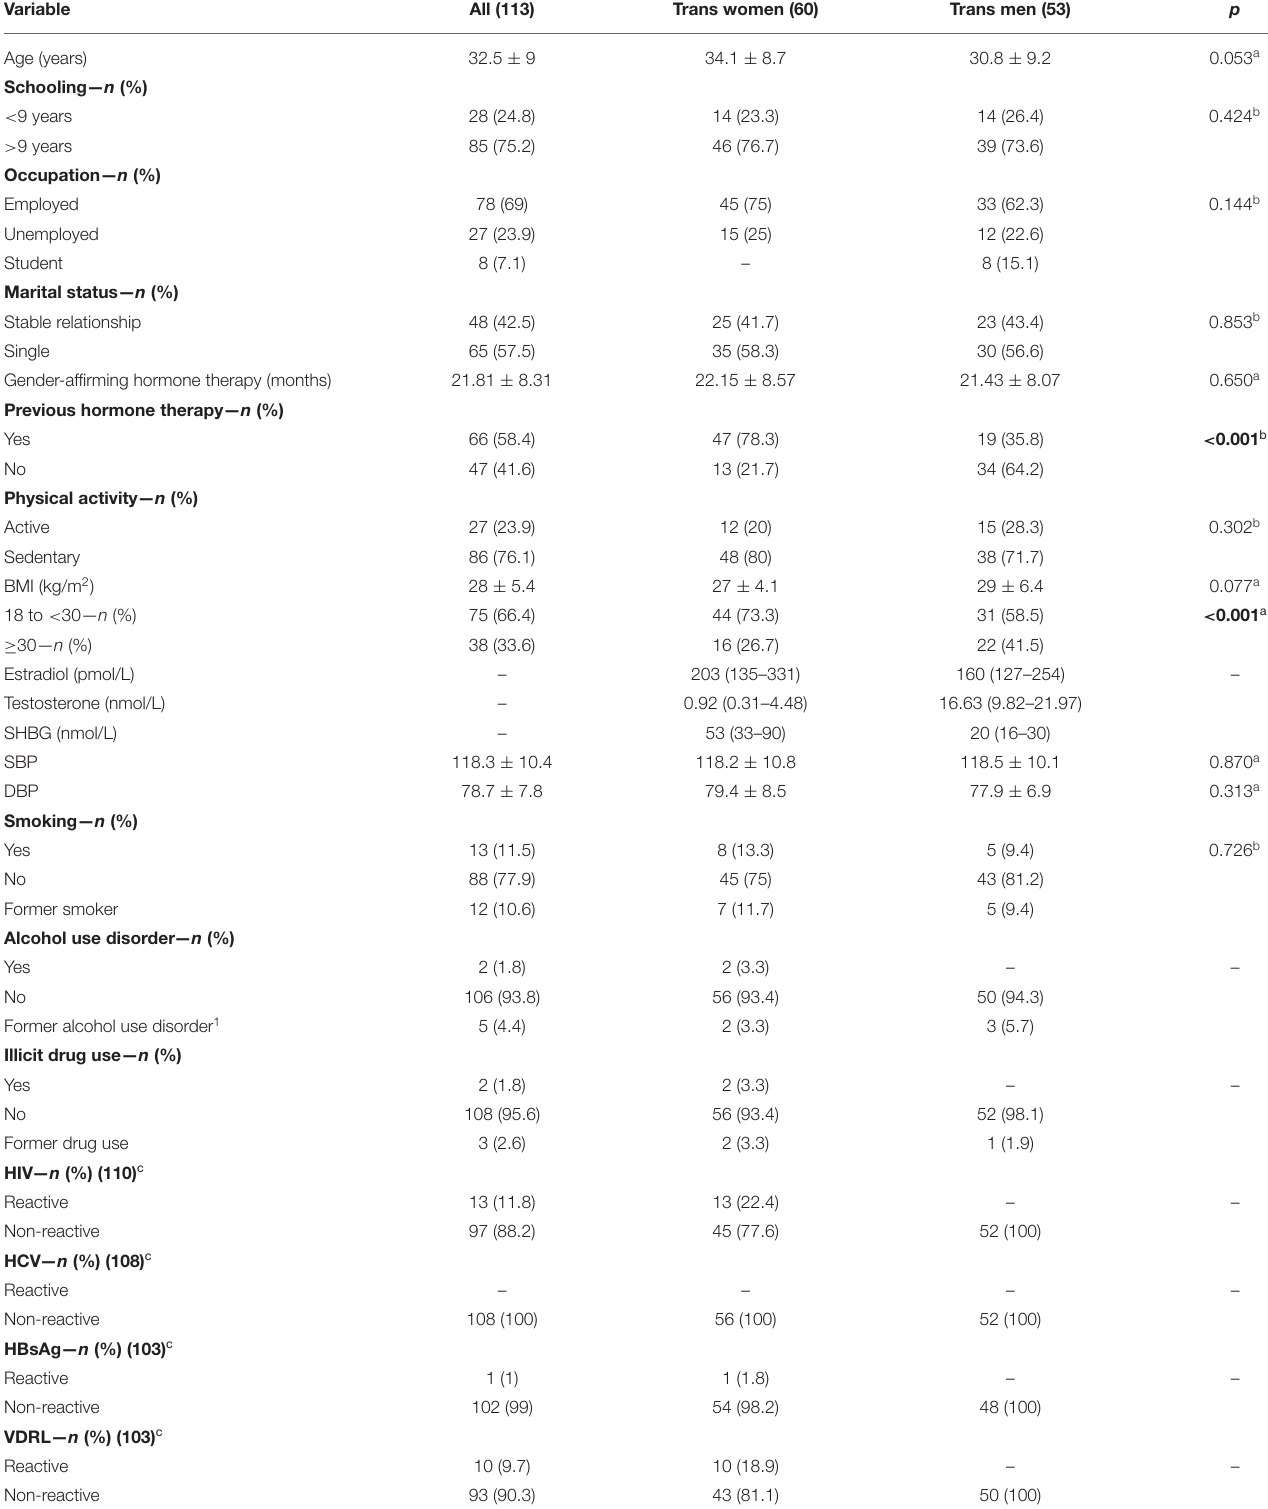
TABLE 1 | Clinical, hormonal, and sociodemographic characteristics of transgender individuals.